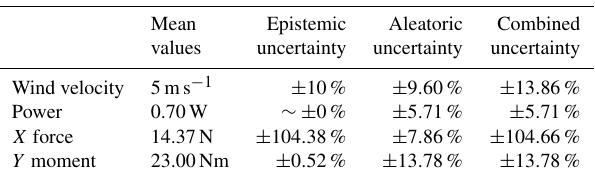
Table 3. The combined uncertainty estimation of the measured val- ues averaged in all the